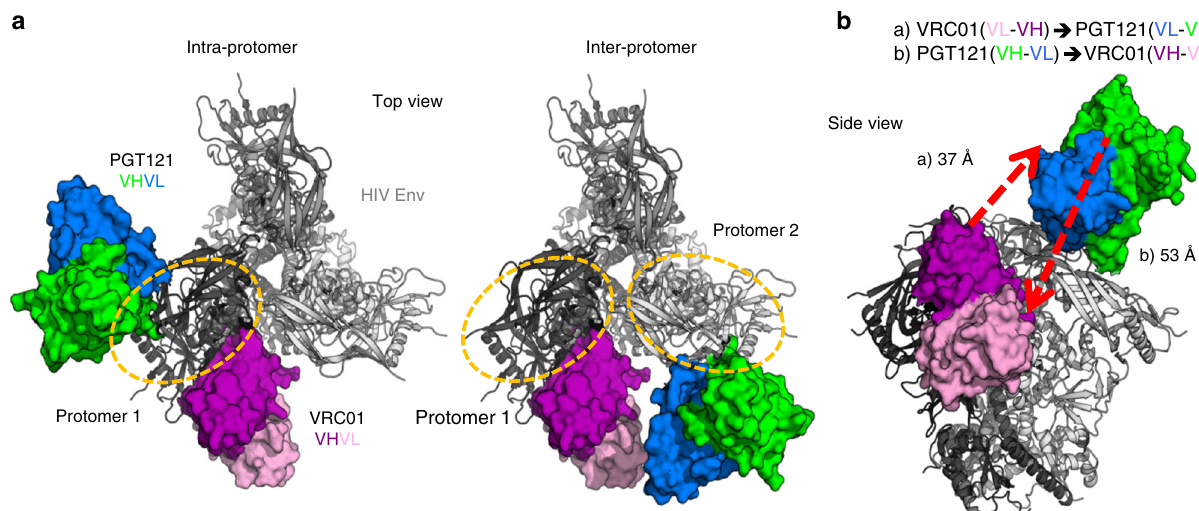
Fig. 1 Design of bispeci fi c antibodies. a Structure of HIV-1 JR-FL SOSIP.664 Env trimer (PDB: 5FYK) showing the footprints of bNAbs VRC01 and PGT121 and their proximity in both intra-protomer (left) and inter-protomer (right) binding con fi gurations. PGT122 serves as a surrogate for PGT121. b Distances between VRC01 and PGT121 VH/VL termini and two Bi-ScFv molecules of different